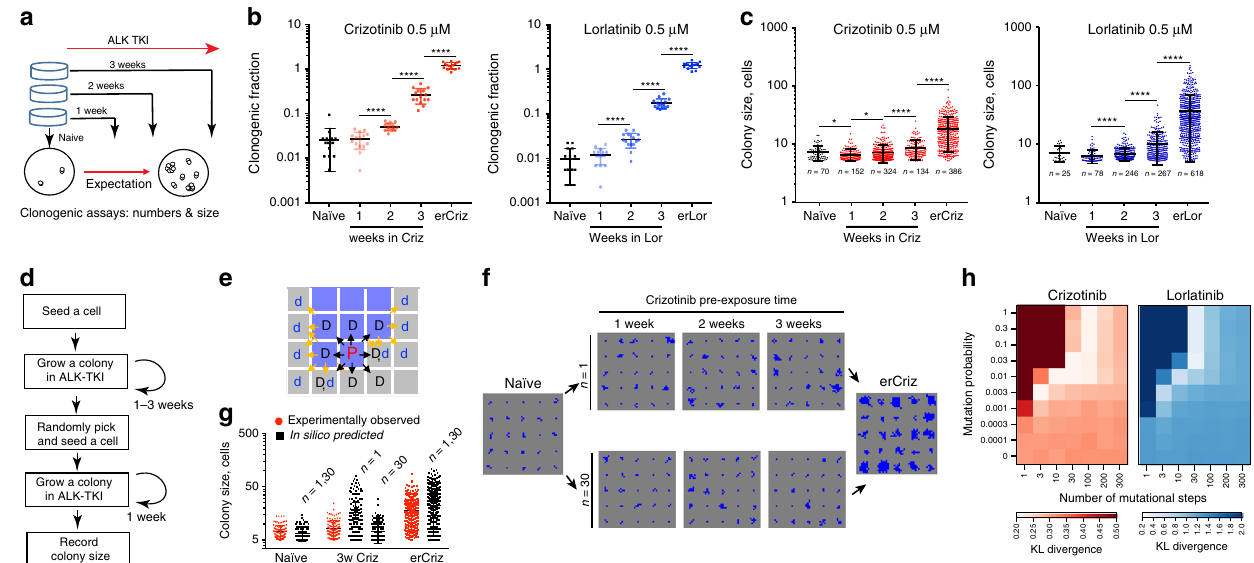
Fig. 3 Graduality of evolution of ALK-TKI resistance. a Experiment schemata. Therapy-naive cells were pre-cultured in the presence of crizotinib or lorlatinib for 0 – 3 weeks, then seeded at clonogenic densities in the presence of ALK-TKIs or DMSO control. After 7 days, numbers and sizes of colonies are determined. b Clonogenic survival in the presence of the indicated ALK-TKIs after pre-incubation for indicated times; data are normalized to clonogenic survival in DMSO control. Mean±SD of 15 replicates (separate wells) is shown. c Distributions of colony sizes in the indicated ALK-TKI. * p < 0.05 and ** p <0.0001 of a Mann – Whitney test. Mean ±SD of individual colonies are shown. d Logical fl ow diagram for the agent-based model, simulating growth during both pre- incubation and the clonogenic assay. e Proliferation space check scheme. Cells are seeded into a 2d lattice that simulates the surface of a culture dish. If space is available (no more than one cell separating the cell from an empty space), a cell can proliferate with a given probability inferred from the experimental data. Blue and gray cells denote occupied and empty spaces respectively. “ P ” stands for the parent cell, “ D ” for daughter cell, “ d ” for displaced cell. Black arrows indicate options for placement of daughter cells, yellow arrows indicate options for displaced cells. Proliferation can occur if a nearby space is either immediately available or separated by a single cell, in which case this cell is pushed into an empty space, with an extra copy of the proliferating cell displacing it. f Example of colony growth simulations, initiated from cells pre-incubated in crizotinib for the indicated time, during the clonogenic growth phase off the assay, contrasting n = 1 vs. n = 30. g Comparing divergence between in silico and experimental data, with n = 1 and n = 30 (epi)mutational steps. Mean±SD of individual experimental and simulated colonies are shown. h Kullback – Leibler divergence-based comparison of the experimental data with the outcomes of simulations, covering parameter space for the indicated mutation probabilities and numbers of mutational